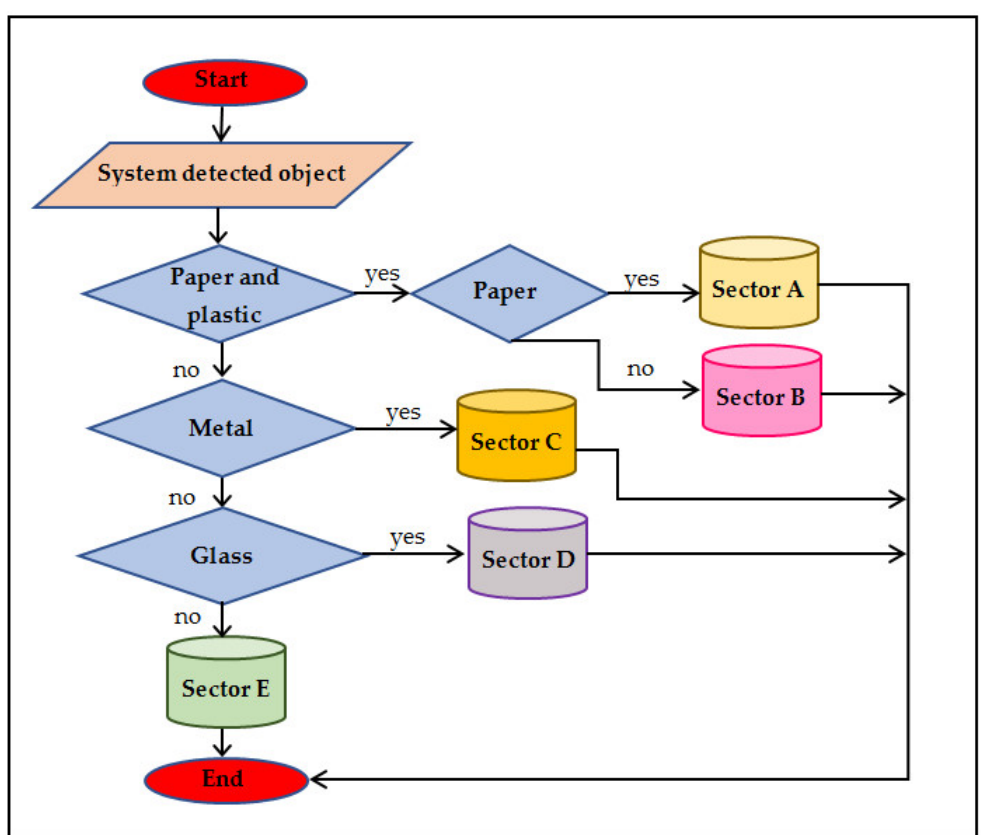
Figure 6. The architecture of Makkah-SWMS [29].